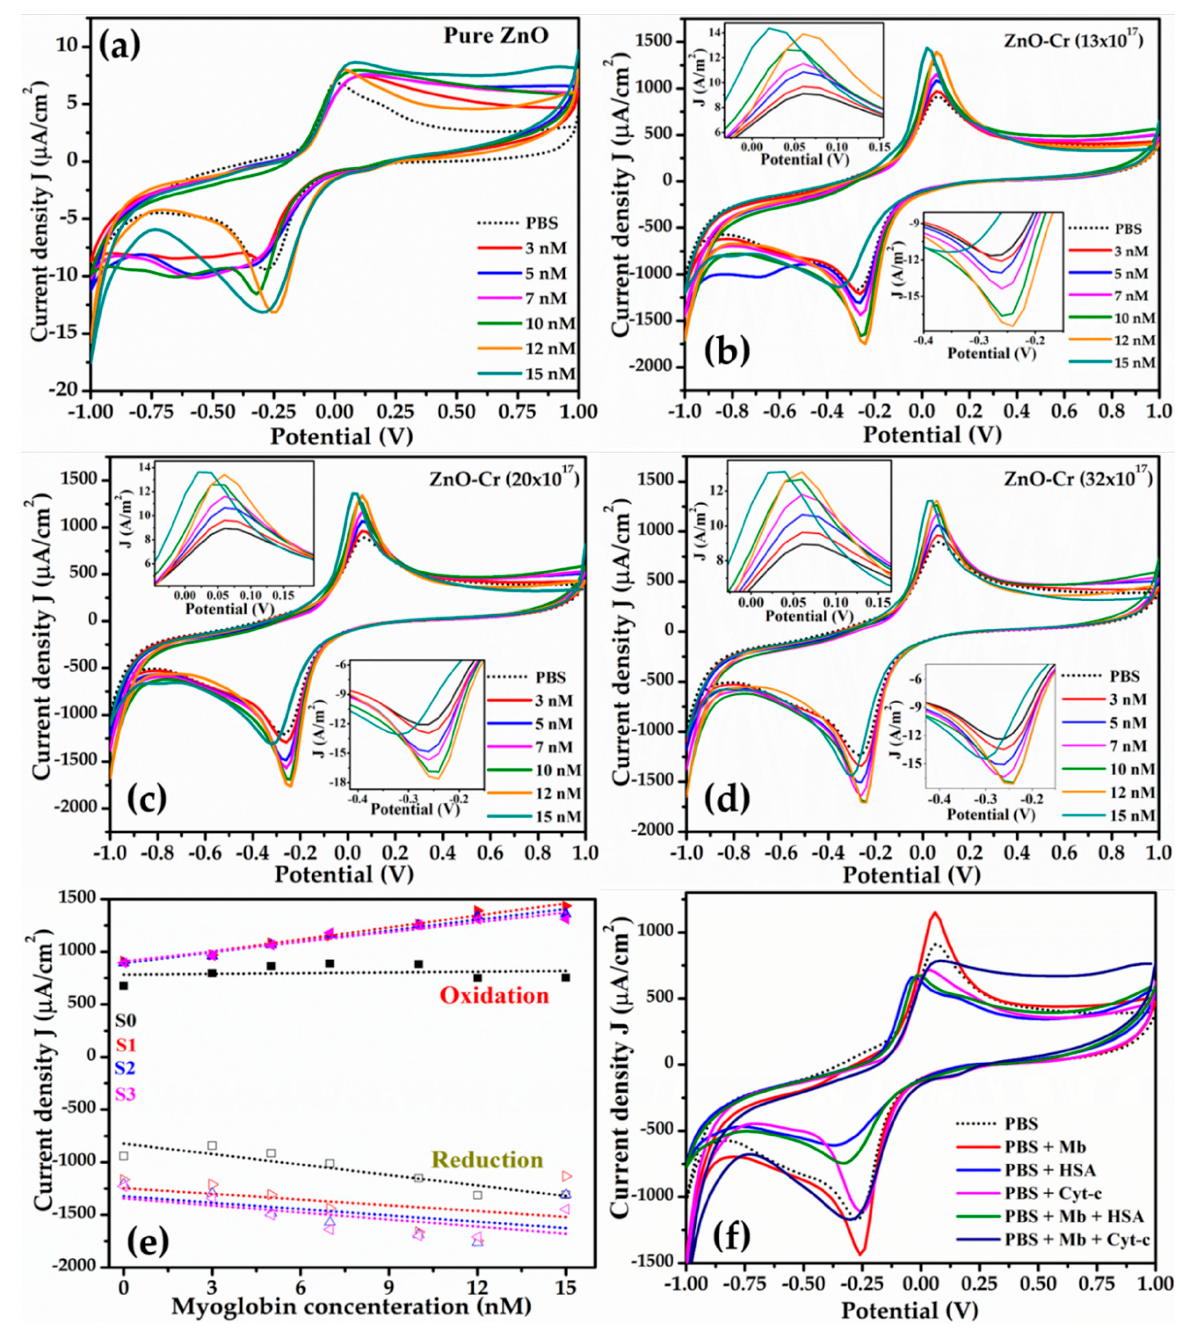
Figure 5. Cyclic voltammetry (CV) curves for pure and Cr-doped ZnO NPs at various concentrations of Mb; ( a ) pure ZnO; ( b ) ZnO-Cr (13 × 10 17 atoms/cm 3 ); ( c ) ZnO-Cr (20 × 10 17 atoms/cm 3 ); and ( d ) ZnO-Cr (32 × 10 17 atoms/cm 3 ). ( e ) Peak oxidation current plotted as a function of Mb concentration (symbol represents experimental data and dotted line is best fit), and ( f ) interference study with HSA and Cyt-c.